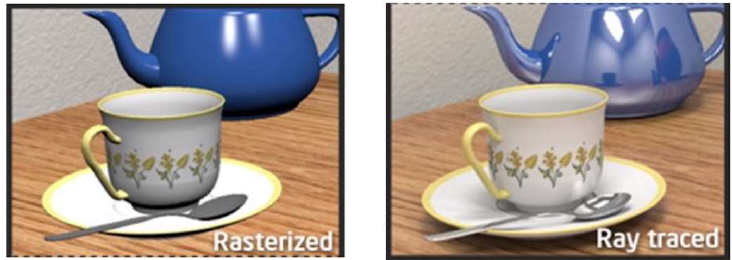
Figure 1. Example pictures of the traditional rasterization and the ray-traced